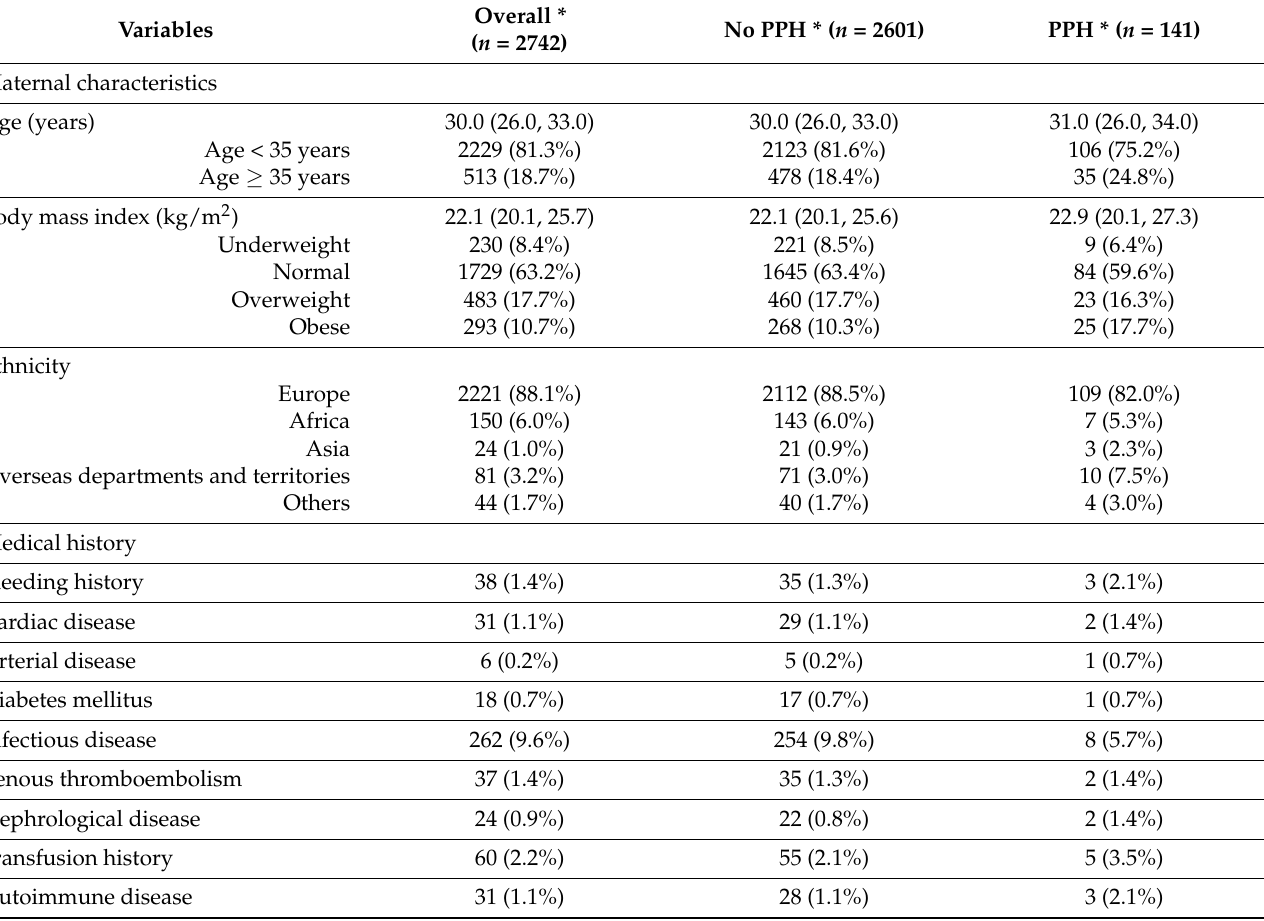
Table 1. Clinical and biological parameters of women with vaginal